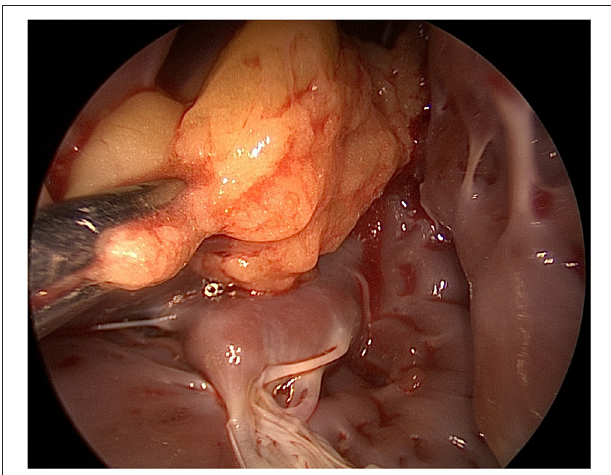
FIGURE 4 | Histopathological examination of the excised mass showed mature adipocytes, consistent with lipoma accompanied by some small vessels and limited collagenous capsule. HandE staining, ×